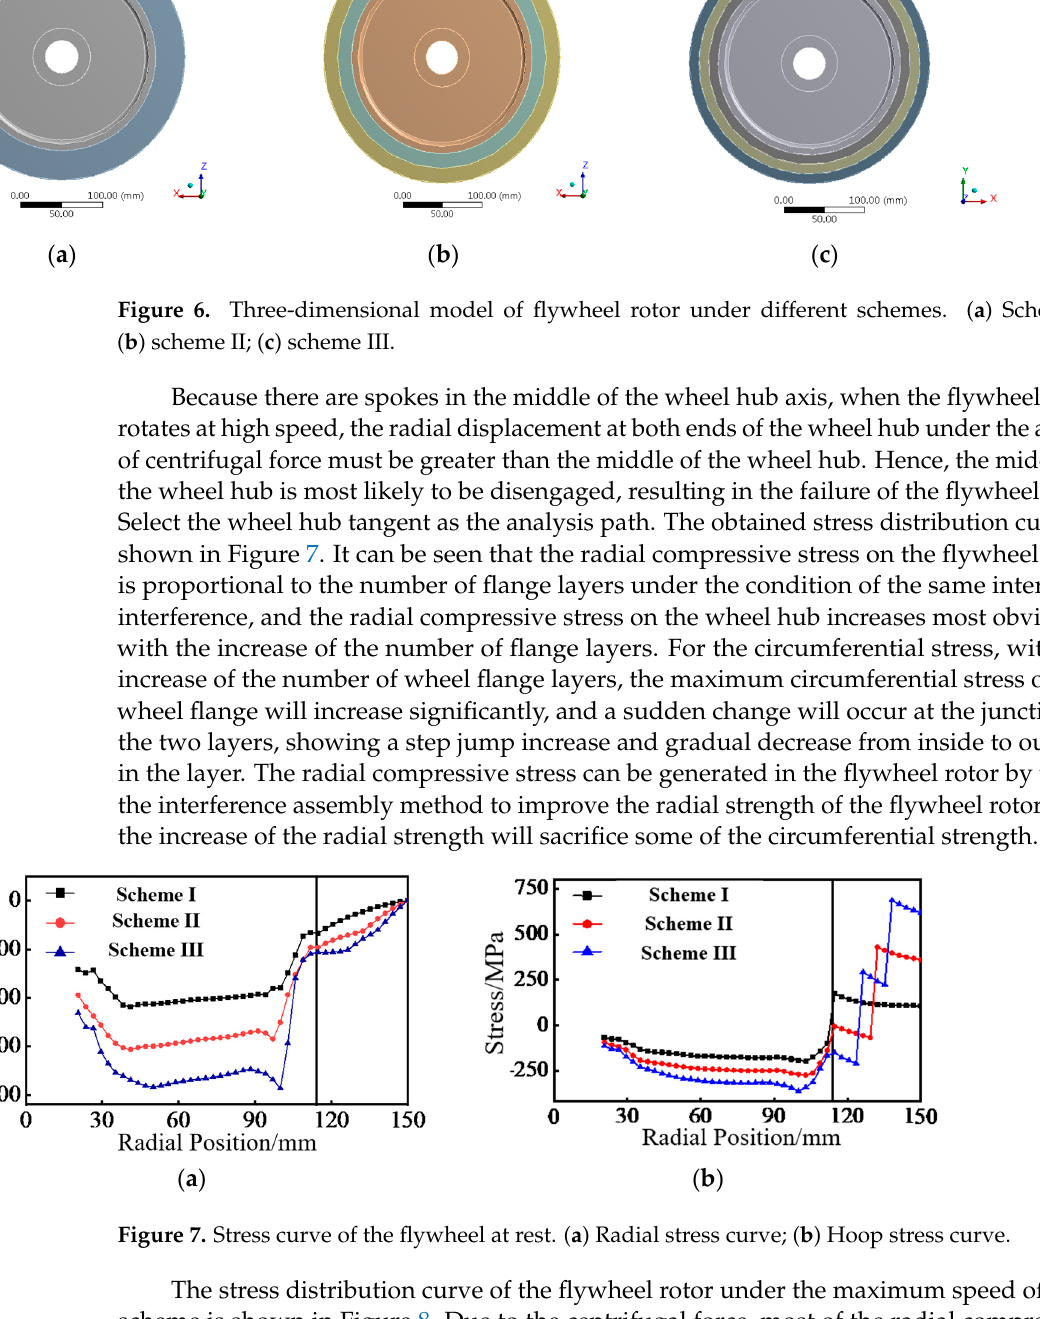
( b ) Figure 8. Stress curve of the flywheel at maximum speed. ( a ) Radial stress curve; ( b ) hoop stress curve. The flywheel rotor assembled with single ring wheel flange interference cannot meet the use requirements when the interference is 0.5 mm. Theoretically, increasing the